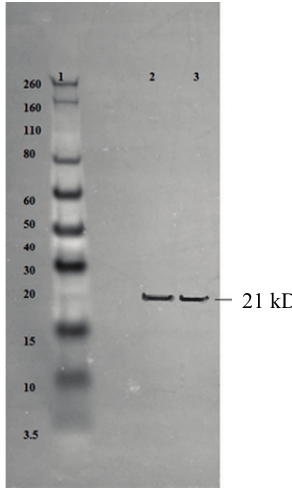
anion exchange (AEX) chromatography.